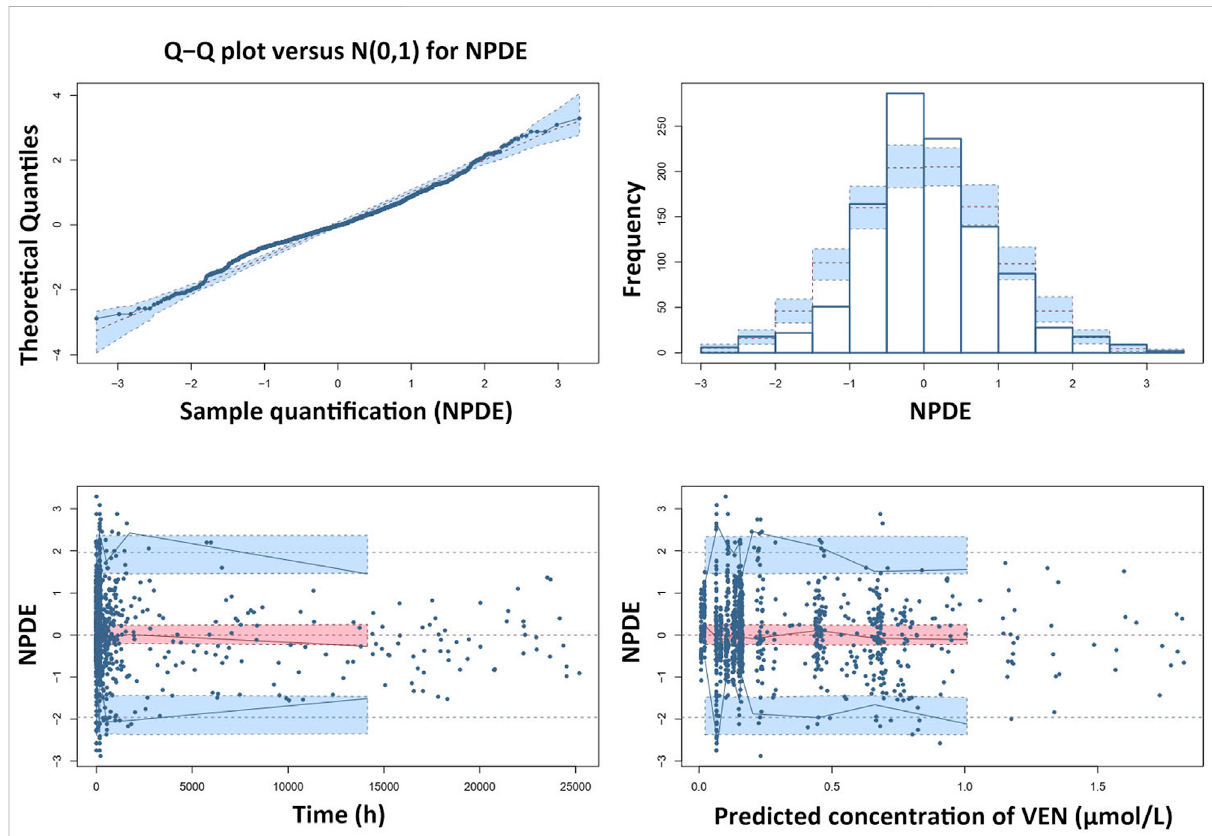
FIGURE 6 Results of the NPDE analysis for VEN. The left upper plot is a QQ-plot for NPDE; the right upper plot is a histogram of the NPDE; the left lower and right lower plots represent the NPDE versus time and the NPDE versus the predicted concentrations of VEN,